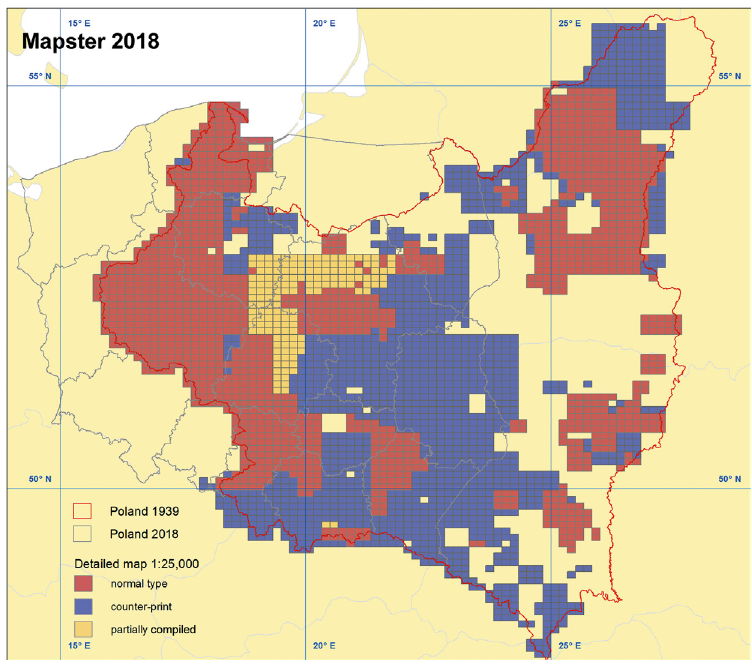
Fig. 3. MGI’s 1:25,000 detailed map sheet types available via Mapster in 2018 (Author’s original